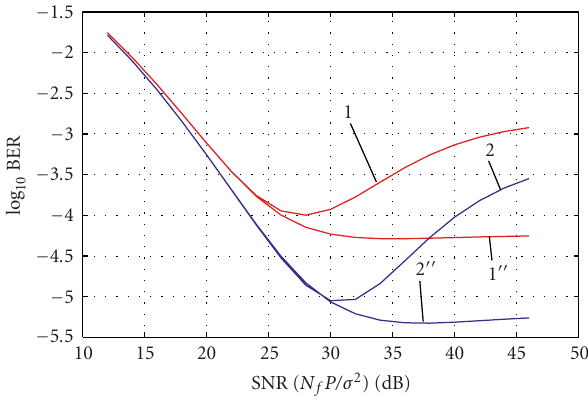
Figure 9: BER performance of MC-CDMA for N f = 16 with MMSE equalizer, averaged over 10 6 realizations of the channel model given in [12] with tap variances normalized such that the total variance is one (Plots 1, 2 are without regularization, plots 1 (cid:7)(cid:7) ,2 (cid:7)(cid:7) are with regularization based on the threshold SNR computed from (26), plots (1,1 (cid:7)(cid:7) ), (2,2 (cid:7)(cid:7) ) correspond to RFOs = 0.05 and 0.03, respectively, and symbols are from 4-QAM constellation with P = 1).